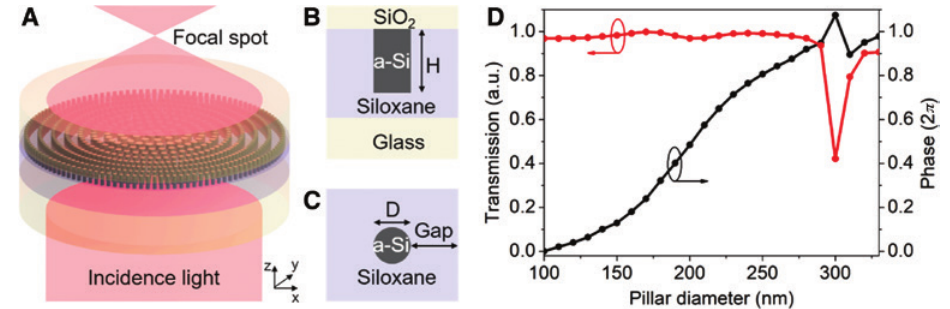
Figure 1: Schematic and unit cell design of the a-Si metalens. (A) Schematic of the metalens. (B) Side view and (C) top view of the metalens unit cell. (D) Simulated phase shift and transmission profile with respect to the pillar diameter. The arrows indicate the corresponding y -axis of the data